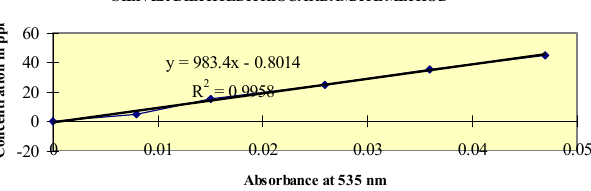
Table 2. Arsenic concentration vs. absorbance. Sr. No.